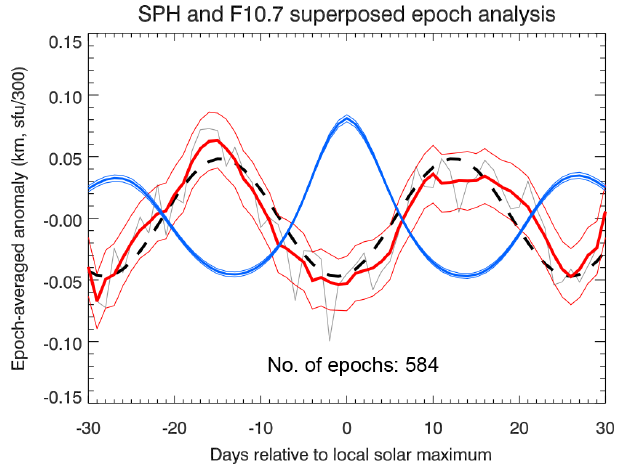
Figure 4. Epoch-averaged standard phase height (SPH) and F10.7cm solar flux anomalies for a total of 584 epochs. The thick blue line corresponds to the epoch-averaged F10.7cm so- lar flux anomaly, and the thin blue lines show the standard errors of the mean for each day relative to local solar maximum. The grey thin line corresponds to the unsmoothed epoch-averaged SPH anomaly, also shown smoothed by a 5-day running mean in red. The thin red lines represent the standard error of the mean of epoch- averaged anomalies about the daily mean value and plotted around the smoothed anomaly to improve clarity. The black dashed line is a sinusoidal fit to the unsmoothed epoch-averaged standard phase height anomaly, with an amplitude of about 50m.